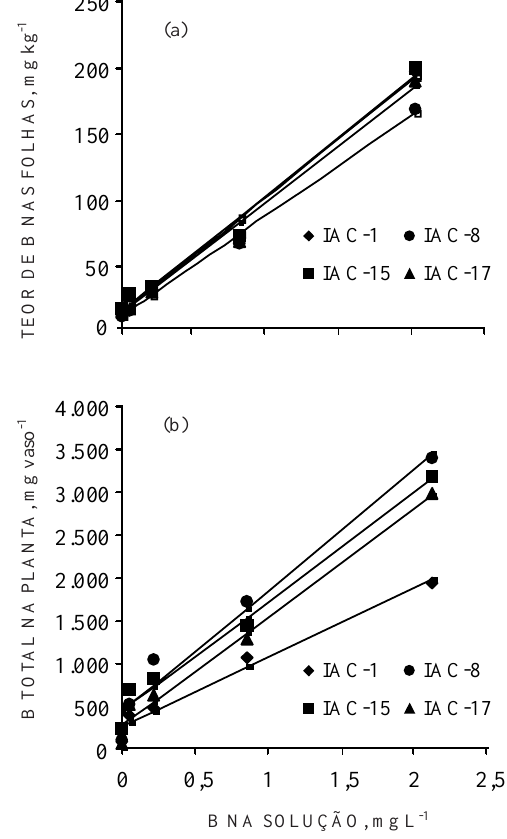
Figura 3. (a) Teor de B na matéria seca das folhas e (b) conteúdo total de B nas plantas (parte aérea + raízes) conforme a concentração de B na solução